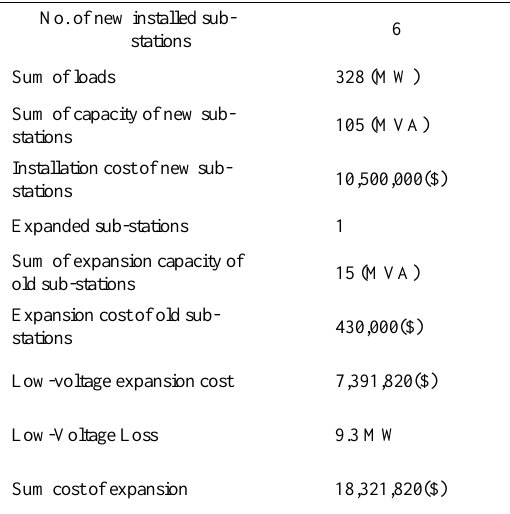
Table 5. Results of applying BFOA to a real network.